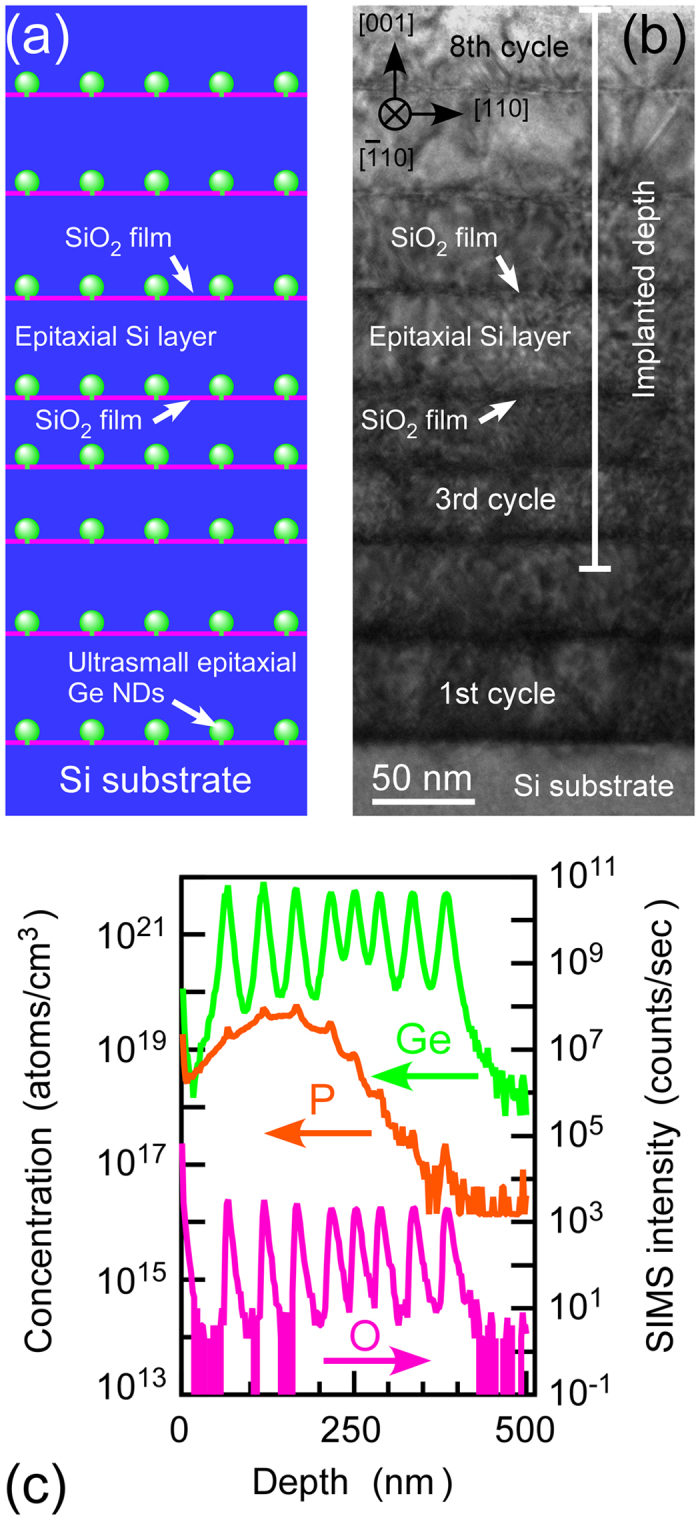
(a) Schematic of our proposed nanoarchtecture; namely stacked structure of epitaxial Ge NDs and Si layers. (b) Cross-sectional TEM image of the typical stacked structure (8-nm NDs/376-ML Si sample) after P ion implantation (110 keV, 4 × 1014 cm−2). Electron beam energy is 200 keV. (c) SIMS profiles of the stacked structure shown in (b).